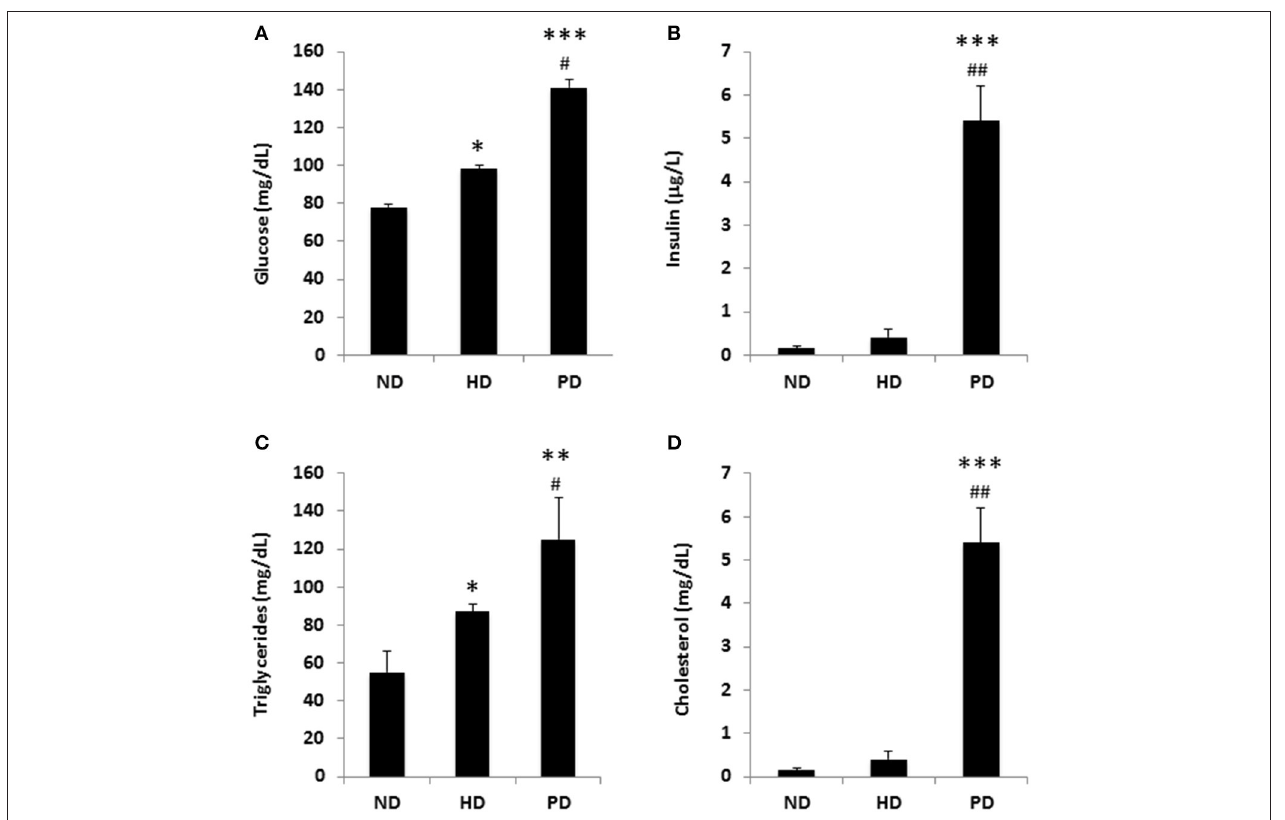
FIGURE 2 | Metabolic parameters of C57BL/6 mice fed a standard normal chow (ND) or a high fat diet (HD) or a Paigen diet (PD) for 15 weeks. (A) fasting glucose; (B) fasting insulin; (C) serum triglycerides; (D) serum cholesterol. N = 4. * p < 0.05, ** p < 0.01, *** p < 0.001 vs. ND; # p < 0.05, ## p < 0.01 vs. HD.